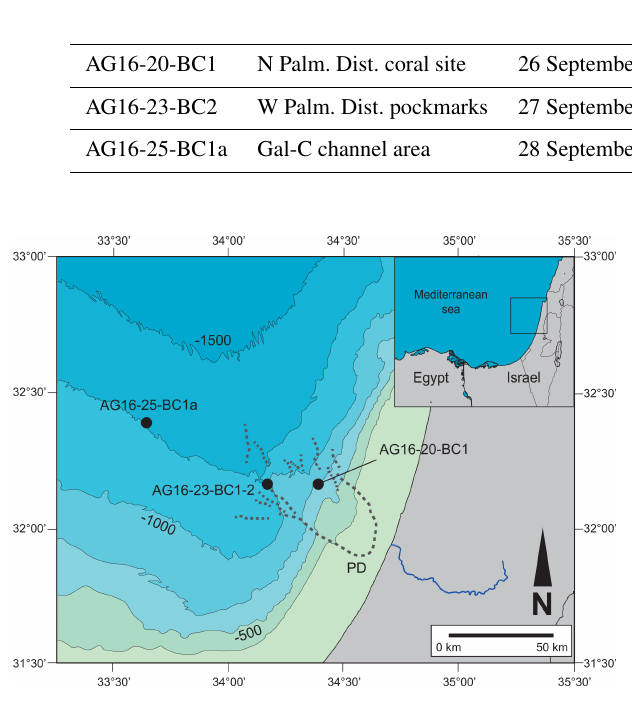
Figure 1. Location map of the studied area. The three stud- ied locations are illustrated: AG16-20-BC1b, coral area (WA5, 690m depth); AG16-23-BC2, pockmark area (WA3, 1038m depth); AG16-25-BC1a, Gal-C channel area (WA2c, 1310m depth). Map created and modified from Generic Mapping Tools (GMT 5; Wes- sel et al.,